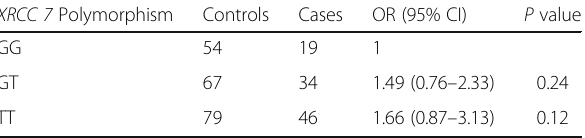
Table 2 Association between polymorphisms of XRCC7 and risk of ALL XRCC 7 Polymorphism